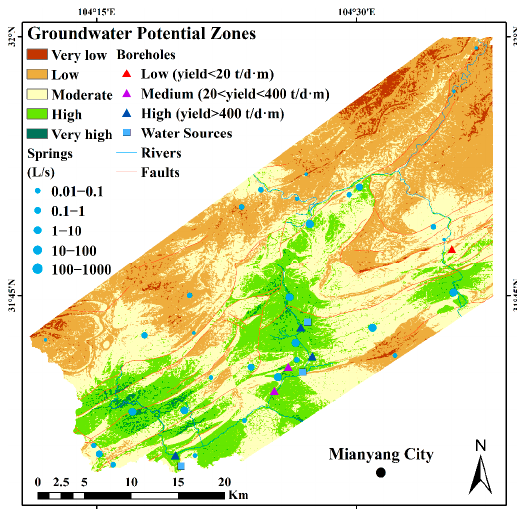
Figure 6. Groundwater potential zones.